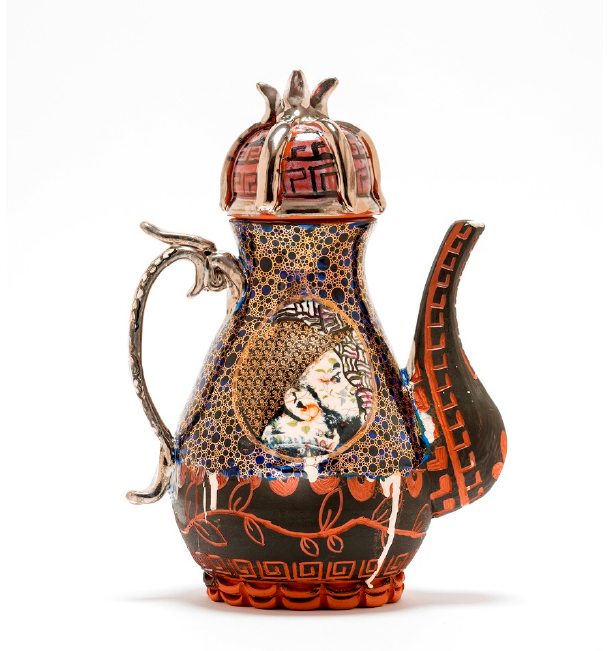
Figure 13. A Queen and I, 2018 , Terra cotta, china paint, luster, 8 × 6 × 11 1/2 in. Image by KeneK Photography, courtesy of Wexler Gallery.